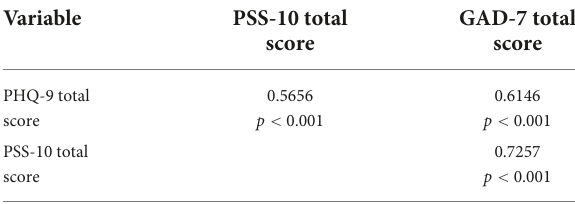
TABLE 7 The Pearson’s correlation (coefficients r, p -values) between the total scores of PHQ-9, PSS-10, and GAD-7.